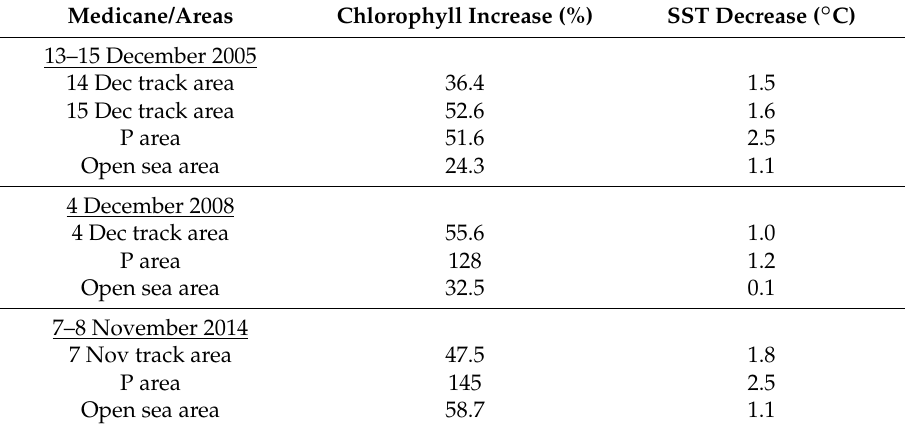
Table 2. Chlorophyll percentage increase and SST decrease of their averaged daily values during a time period of ~11-days centered on the event, for the oligotrophic open sea area, the 50 km width along-track area, and the areas of positive chlorophyll differences